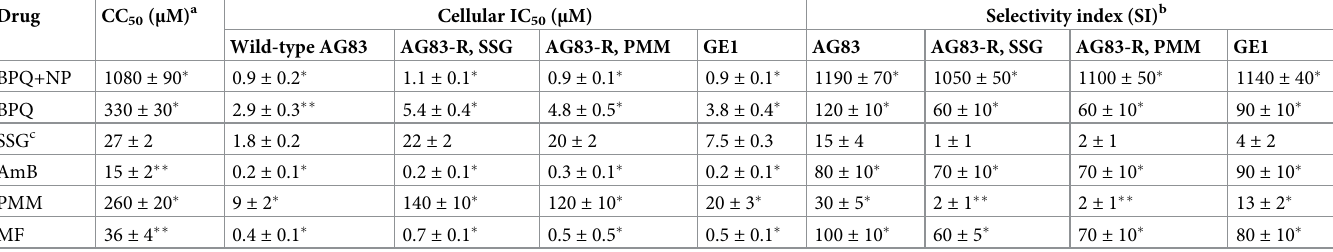
Table 3. Drug sensitivity profiles against intracellular L .donovani amastigotes (mean ± σ , n = 4). Drug CC 50 ( μ M) a